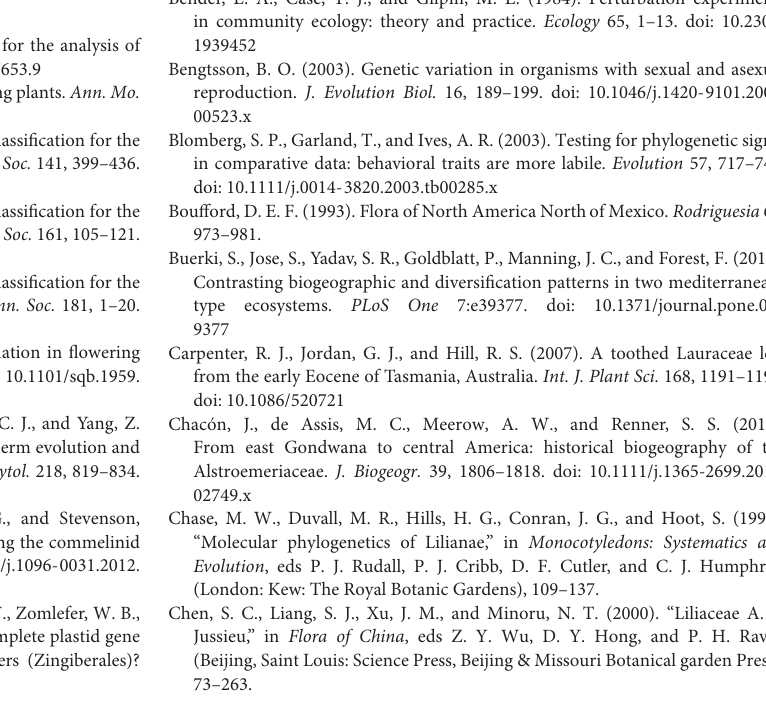
Supplementary Figure 1 | Phylogenetic tree resulting from a maximum likelihood (ML) analysis based on the Lilieae whole plastome (WP) matrix. Supplementary Figure 2 | Phylogenetic tree resulting from an ML analysis based on the Lilieae plastid coding sequences (CDSs) matrix. Supplementary Figure 3 | Phylogenetic tree resulting from a Bayesian inference (BI) analysis based on the Lilieae plastid CDSs matrix. Supplementary Figure 4 | Phylogenetic tree resulting from an ML analysis based on Lilieae nuclear ITS